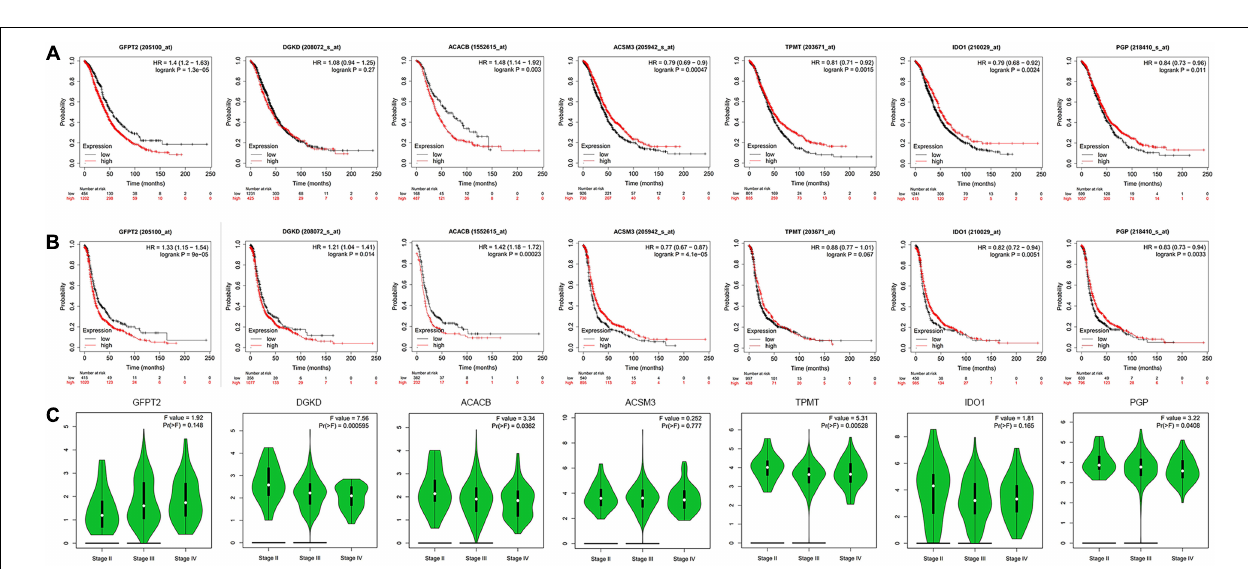
FIGURE 2 | Evaluation of the performance of the risk model. (A,D) Distribution of risk score in patients. (B,E) Survival status scatter plots of patients (red dots represent death, blue dots represent alive). (C,F) The seven-gene expression patterns in the training cohort. (A–C) from TCGA database. (D–F) from GEO database.